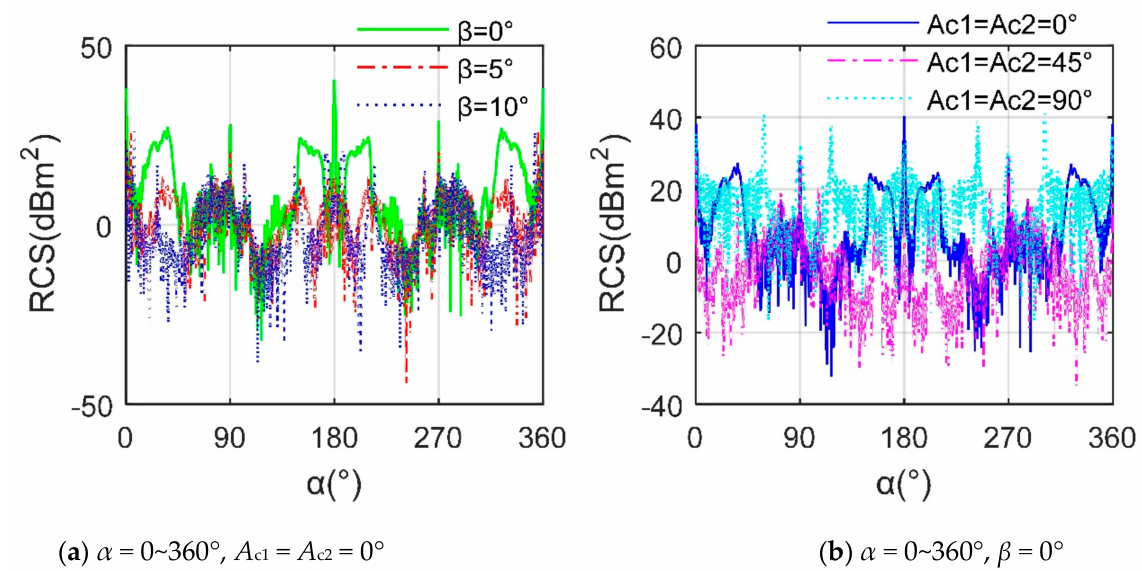
Figure 11. RCS of the tilt rotor aircraft, f rh = 10 GHz, t = 0 s, n r1 = n r2 = 1500 r/min. ( a ) RCS curves at α = 0~360 ◦ , A c1 = A c2 = 0 ◦ . ( b ) RCS curves at α = 0~360 ◦ , β = 0 ◦